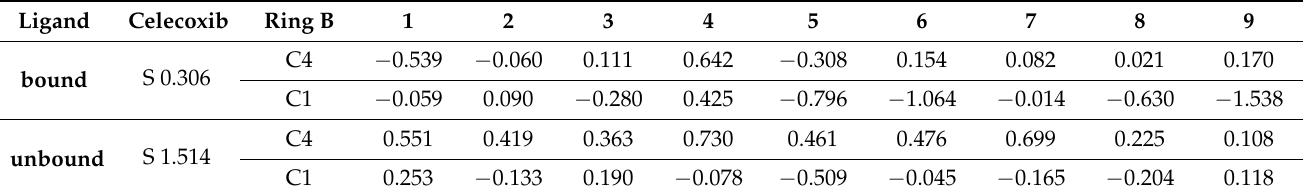
Table 2. Mulliken atomic charges of the aromatic carbon atoms of oxyresveratrol analogues and a sulfur atom, and the electron acceptor in